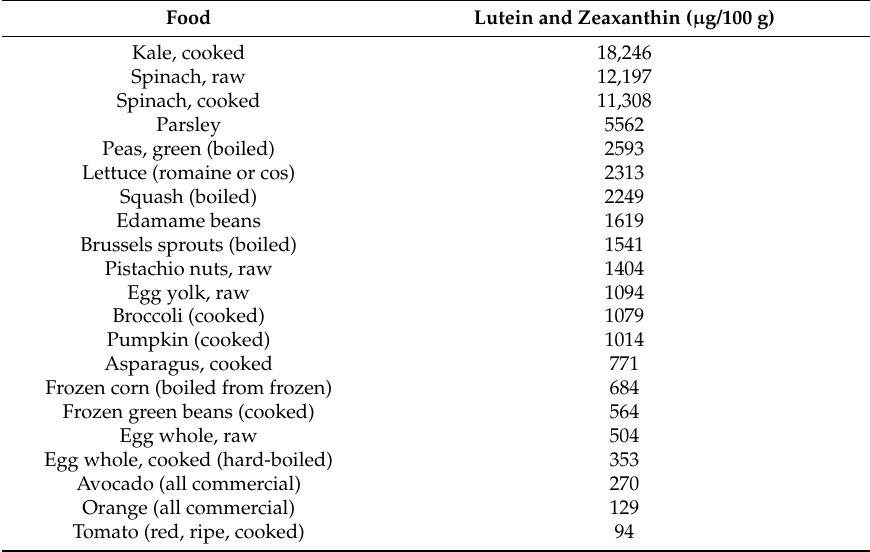
Table 5. Lutein and zeaxanthin content of common foods